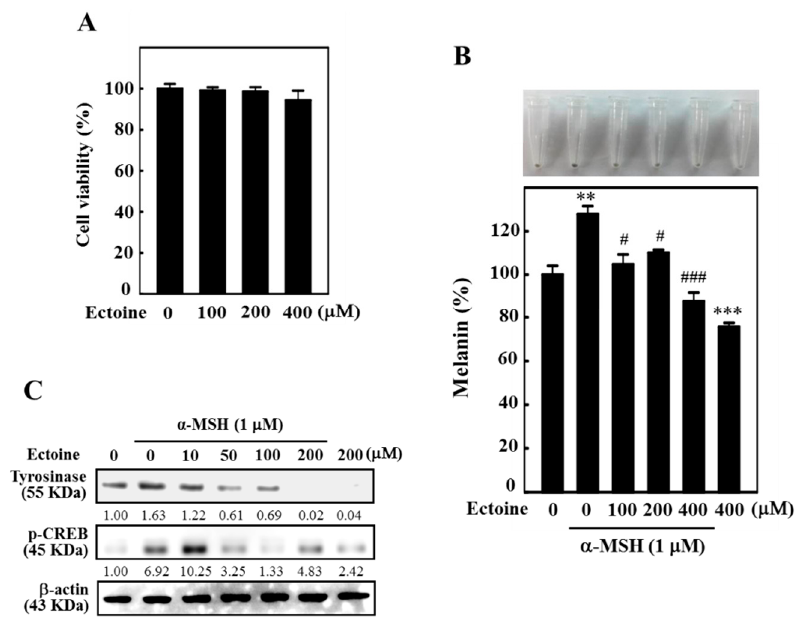
Figure 3. Ectoine downregulated the melanogenesis in α -MSH-stimulated B16F10 cells. ( A ) High concentrations of Ectoine (100–400 μ M, 72 h) affect the cell viability of B16F10 as determined by an MTT assay. ( B ) Cells were pre-treated with Ectoine (0–400 μ M, 1 h) followed by stimulation without or with 1 μ M α -MSH for 72 h. The percentage of melanin content was quantified from total cell lysates.